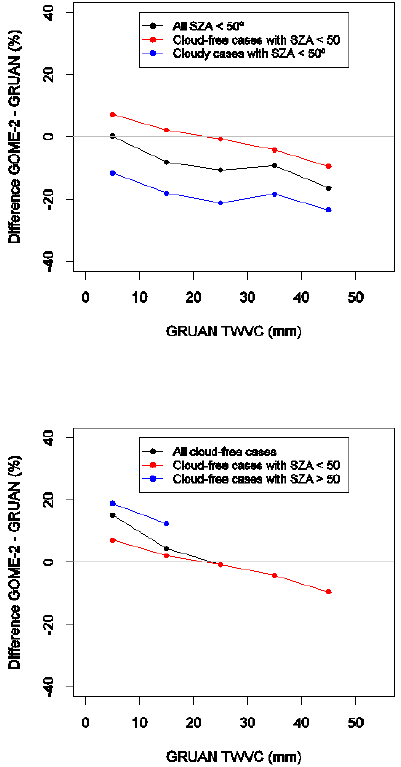
Figure 8. Differences between GOME-2 and GRUAN sounding data (Eq. 3) as function of the GRUAN TWVC values for cases with SZA below 50 ◦ (top plot) and cloud-free cases (bottom